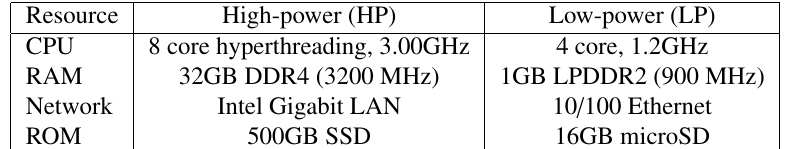
Table 1. Computational resources of each testing